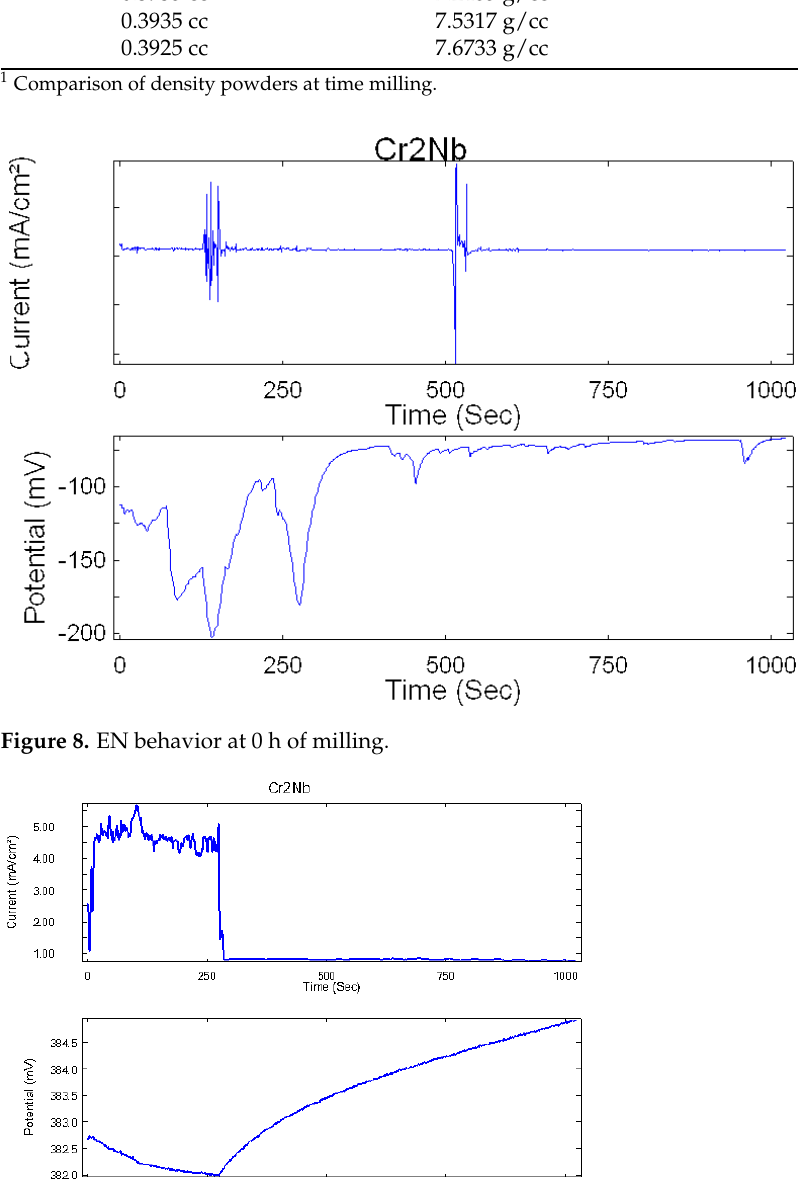
Figure 10. EN behavior at 20 h of milling. Figure 11. Line scan of the presence of elements in samples. In order to understand the influence of the position of Cr or Nb particles on the toughening and oxidation resistance, MA was applied during the alloy processing [26].